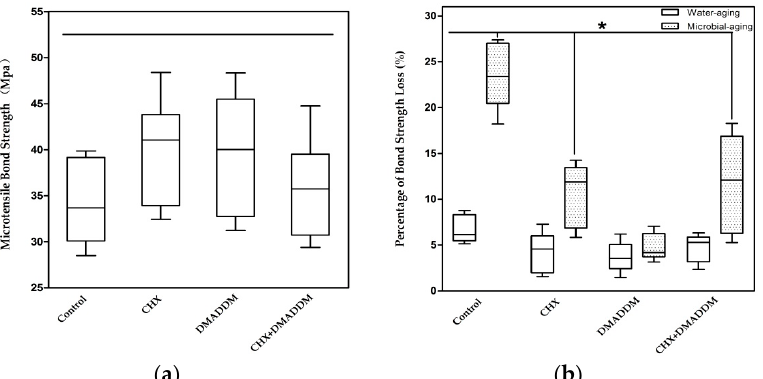
Figure 1. Microtensile Bond testing: ( a ) The microtensile bond strength without aging treatment; and ( b ) the percentage of microtensile bond strength lost after water aging and microbial aging ( n = 6). The asterisk represents statistically significant differences; * p < 0.05.